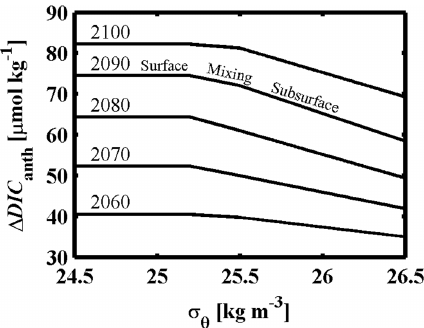
Figure 2. (cid:49) DIC anth as a function of σ θ for certain modeled years (indicated above line) using the IPCC RCP6.0 projection. The three regimes used in this model – surface, mixing, and subsurface – are